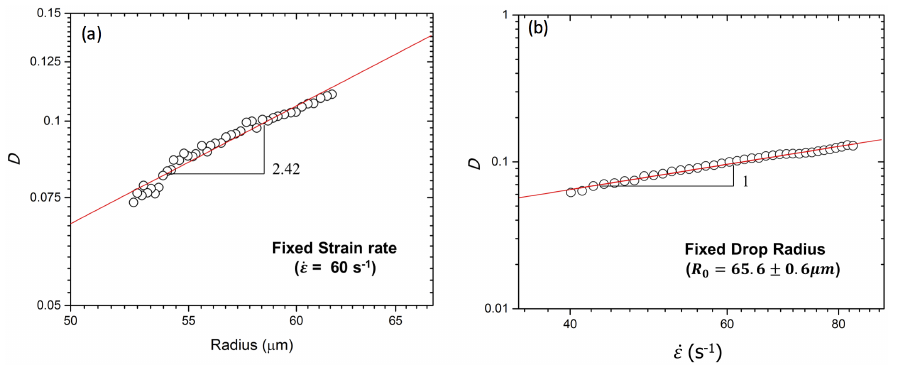
Figure 4. Droplet deformation D in a microchannel with channel height h = 80 µ m: ( a ) Dependence of the droplet size at a constant strain rate ˙ ε = 60 s − 1 , ( b ) dependence of the strain rate at a constant droplet radius R 0 = 65.6 ± 0.6 µ m. The symbols and the solid lines correspond to experimental data and power law fits,